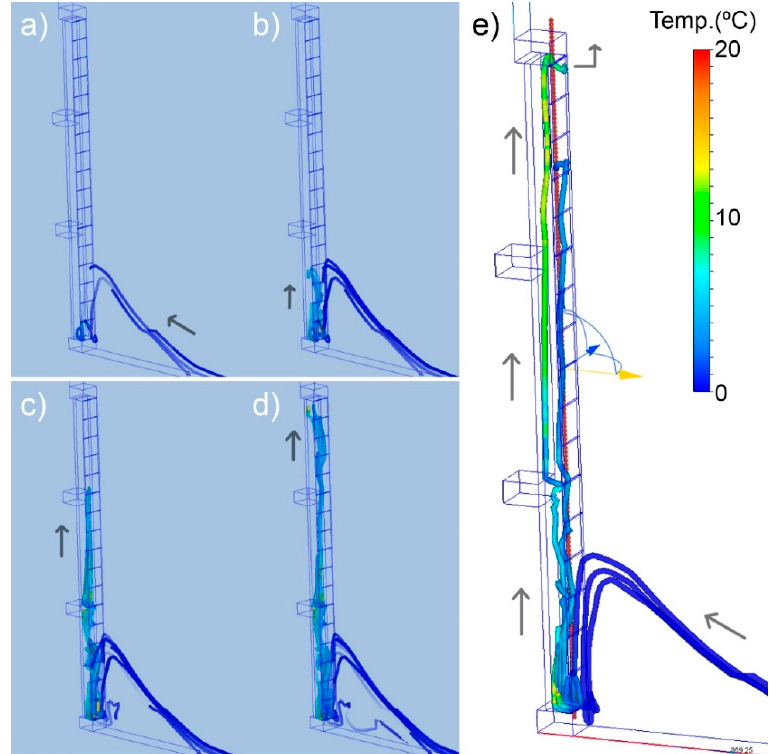
Figure 4. Displacement and temperature of the air particles inside the chamber. From ( a ) to ( e ) steps of the air flow.